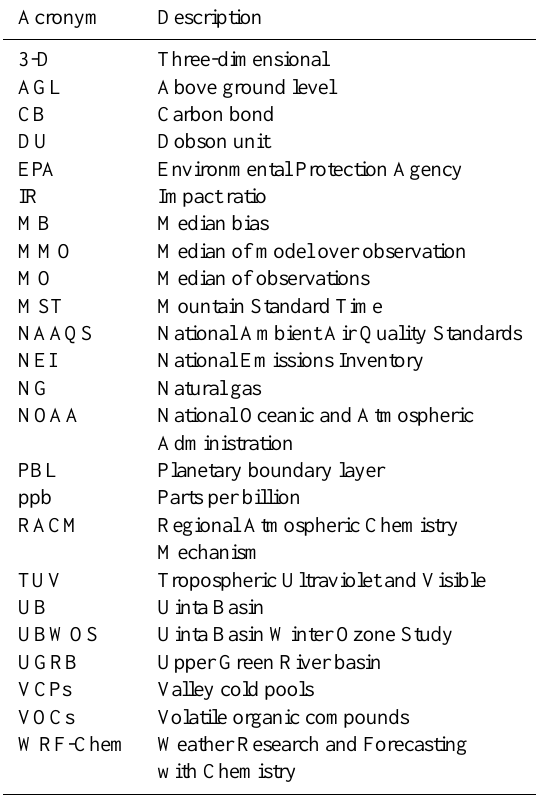
Table 1. List of acronyms used in the